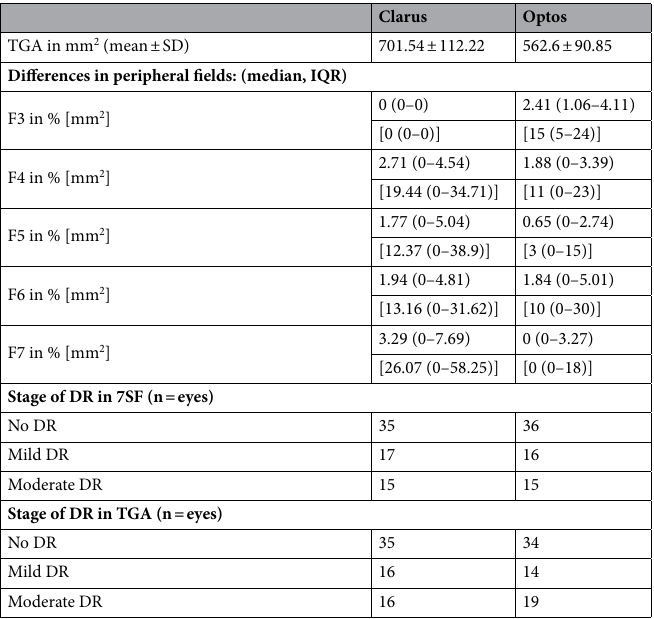
Table 1. Measurements for Clarus and Optos device. 7SF 7 standard fields, DR diabetic retinopathy, IQR interquartile range, SD standard deviation, TGA total gradable area. TGA is the area measured excluding eyelashes or distortions. Difference in the peripheral fields F3–F7 corresponds to the area not seen on the other device due to eyelashes or distortions observed through comparison of anatomical landmarks and is given in percentage of the TGA and in mm 2 as measured on both